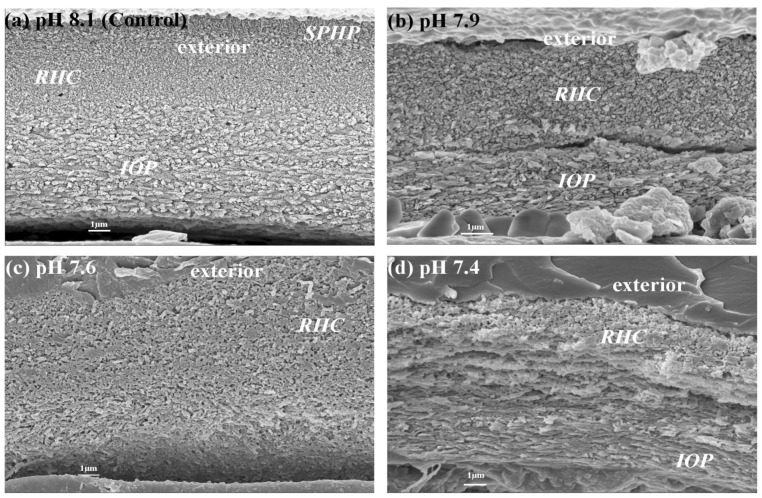
Effects of pH/pCO2 on cross sectional views of the tube ultrastructures in the juvenile tubeworm, Hydroides elegans.Abbreviations: SPHP, spherulitic prismatic structure; IOP, irregularly oriented prismatic structure; RHC round homogenous crystal structure.